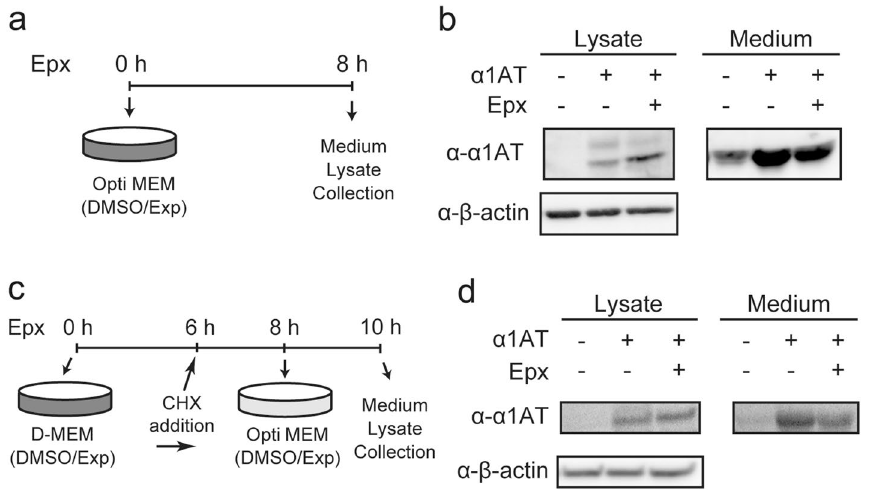
Figure 4. Protein secretion activity was decreased under the reductive redox state in the ER after proteasome inhibition. ( a , c ) Experimental design to determine the amount of secreted proteins (( a ) for ( b ) and ( c ) for ( d )). Cells were transfected with expression vectors and incubated for 24 h. Then, the medium was exchanged to Opti-MEM containing DMSO and Epx (1 μM), and the cells were incubated for 8 h. In ( c ), after 24 h of the transfection, DMSO or Epx was added and the cells were incubated for 6 h. The medium was then exchanged to a Opti-MEM containing 50 µM cycloheximide (CHX) and, DMSO or Epx, and the cells were further incubated for 2 h. Finally, the medium was exchanged to a new Opti-MEM containing DMSO or Epx. ( b , d ) Immunoblotting of secreted or intracellularly retained hα1AT. Secreted proteins were prepared by TCA precipitation and then separated by